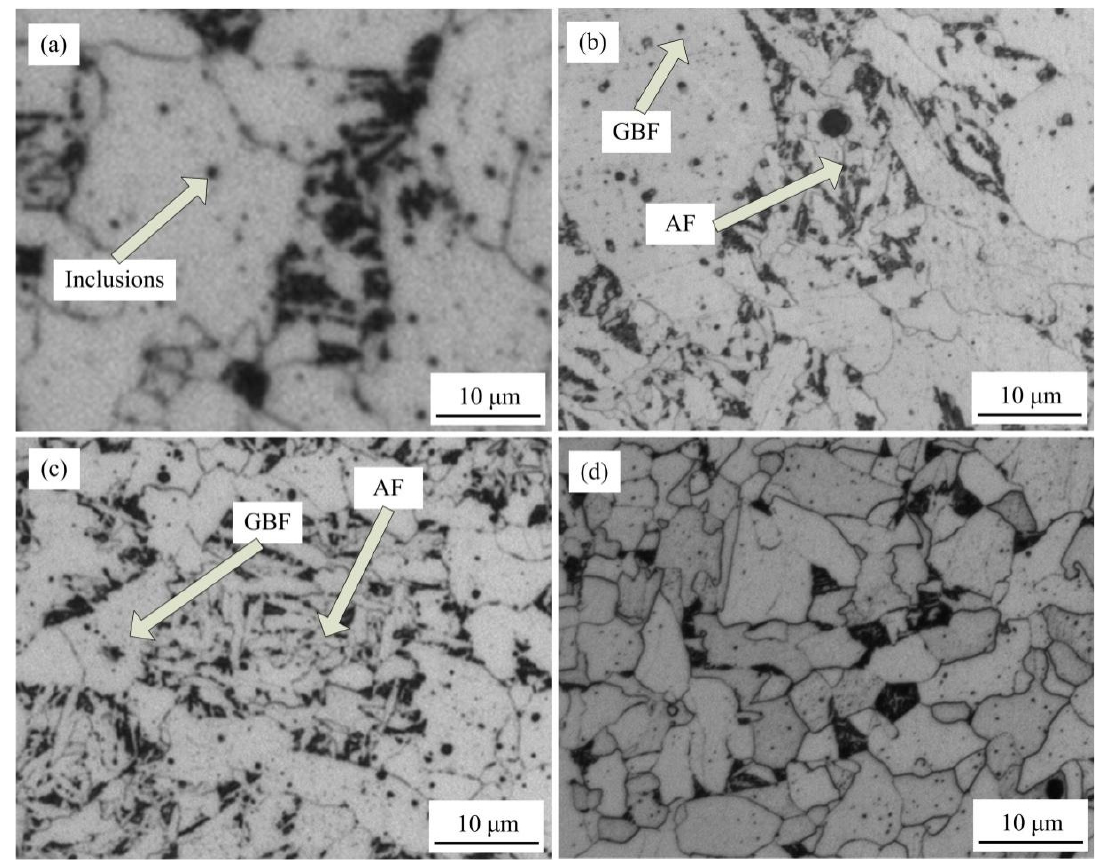
Figure 2. Microstructures of the weld metal after continuous cooling at different rates: ( a ) 1 °C/s, ( b ) 5 °C/s, ( c ) 10 °C/s, and ( d ) 100 °C/s.